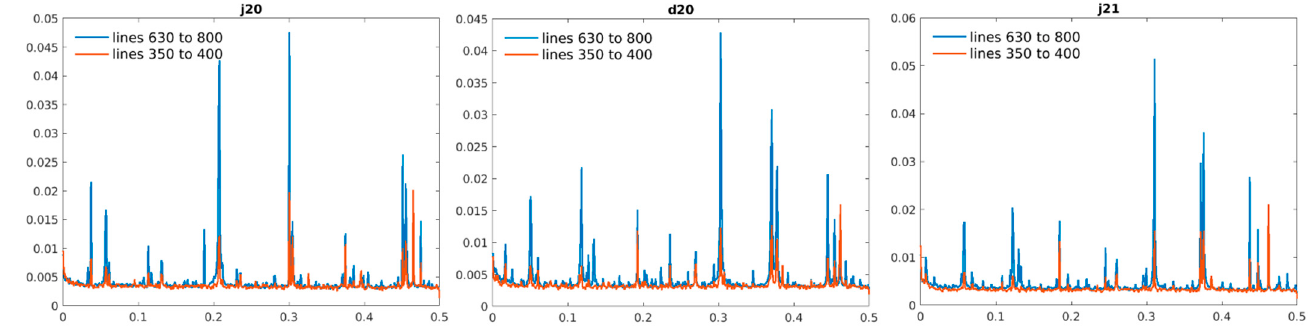
Figure 9. Horizontal FFT averaged over the selected lines of the residual noise for 2198.91 nm spectral band of different Pignola scenes: July 2020 (j20); December 2020 (d20); July 2021 (j21). In each image, the horizontal axis is cycles/pixel, and the vertical axis shows the single-sided amplitude spectrum of the noise signal.